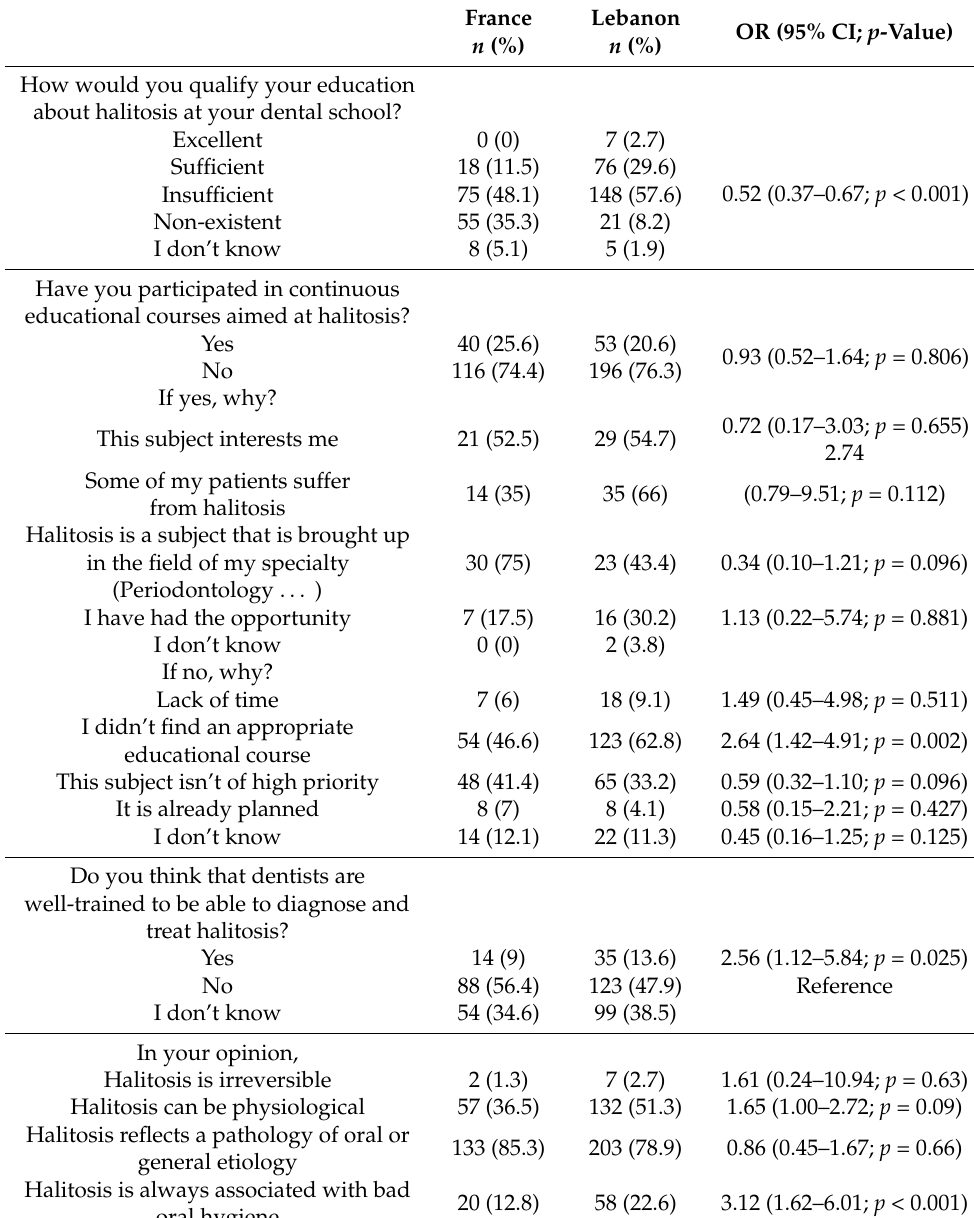
Table 5. Halitosis related knowledge of FD and LD. Difference between LD and FD when adjusted for gender, age, and professional experience. A p < 0.05 was considered significant. (OR: odds ratio, CI: confidence